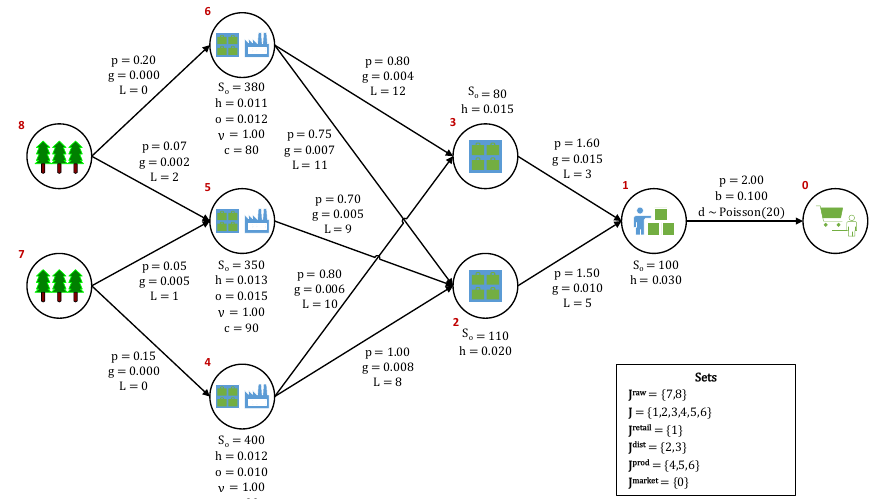
Figure 5. Supply Chain Network Schematic with Network Parameters used in the Case Study.